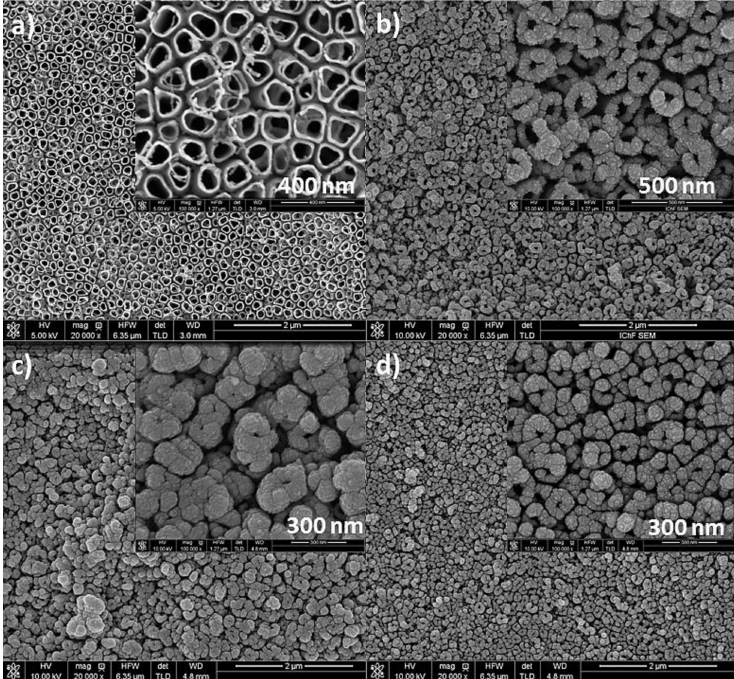
Figure 1. SEM images of a nanotubes formed at 25 V, annealed at 450 ◦ C / 1h ( a ) with a metal deposits: